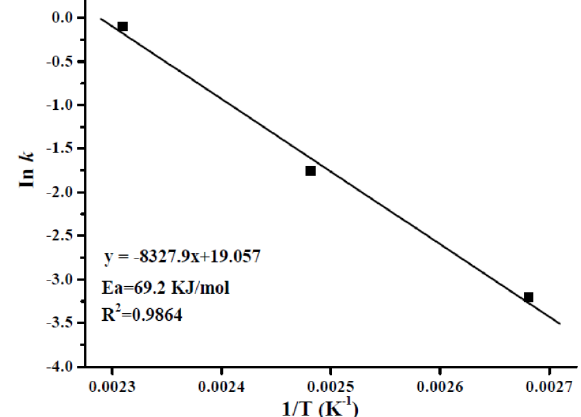
Figure 8: Arrhenius plot of the esterification of oleic acid with methanol over NiHSiW/UiO-66 to obtain the activation energy (E